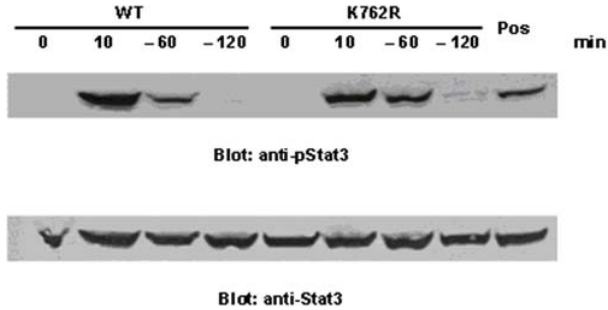
Figure 5. G-CSF-induced Stat3 activation is similar in WT and K762R transfectants. BaF3 cells stably transfected with either the WT G-CSFR or K762R/G-CSFR were washed and incubated in cytokine-free media (RPMI/0.1%BSA) at 37 u C for 4 hrs. Cells were then treated with G- CSF (100 ng/ml) at 37 u C for 10 min, washed, and incubated again in cytokine-free media for the indicated times, then lysed. Proteins from whole cell lysates were separated on SDS-PAGE and transferred onto nitrocellulose membranes, which were blotted with anti-phospho-Stat3 antibody (upper panel). The blot was stripped and re-blotted with anti- Stat3 antibody to confirm equal protein loading (lower panel). Cells stimulated with activated orthovanadate at room temperature for 20 min are shown as a positive